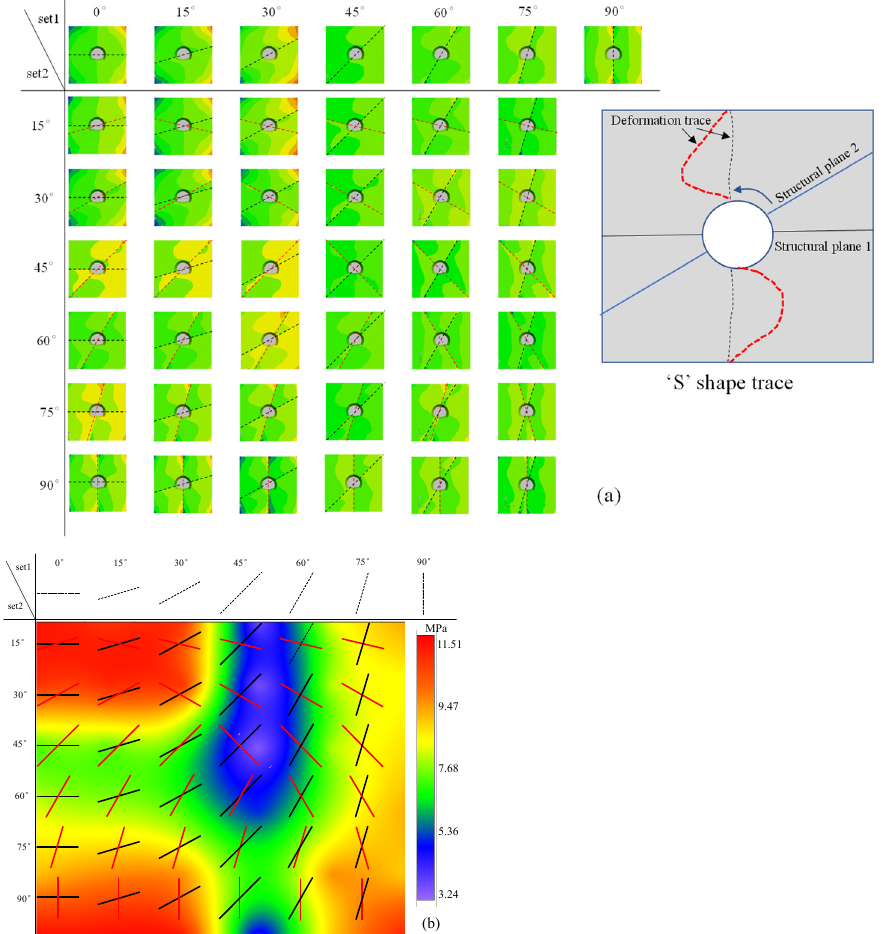
Figure 16. Deformation results of rock mass structural plane combinations. ( a ) Horizontal deformation cloud map, ( b ) strength distribution.